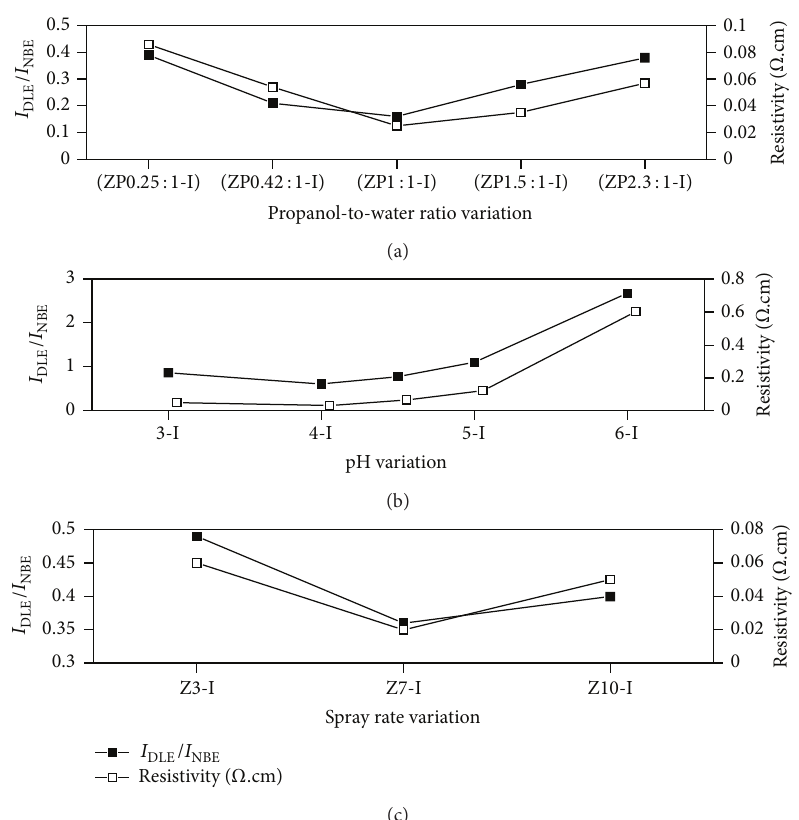
/𝐼 Figure 3: Variation of 𝐼 and resistivity for (a) different propanol-to-water ratios in the solvent, (b) various pH of spray solution, and DLE NBE (c) different spray rates.